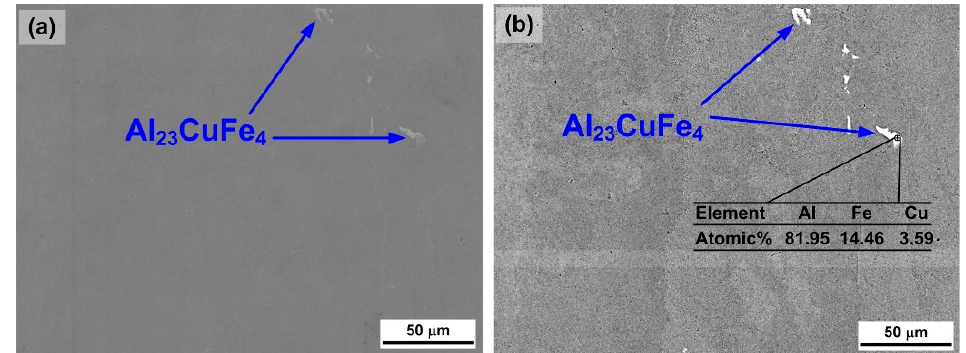
Figure 3. Surface morphology of as-received 7075 aluminum alloy: ( a ) secondary electron image and ( b ) backscattered electron image.